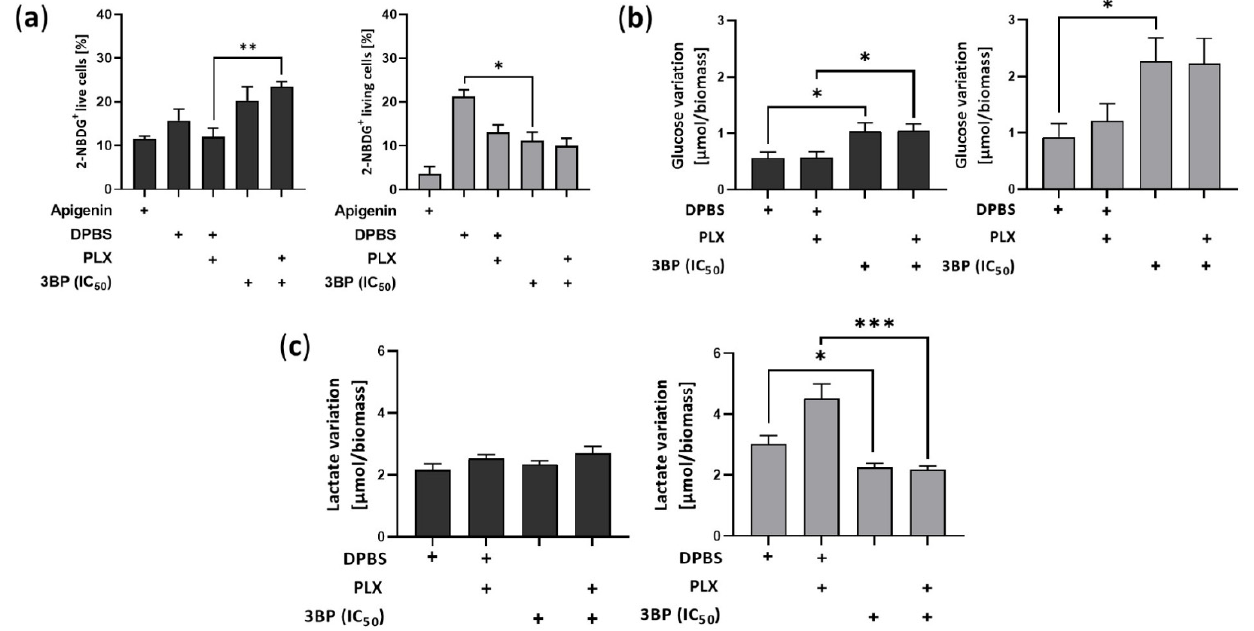
Figure 3. Analysis of variation in extracellular glucose and lactate levels in vemurafenib (PLX)-resistant melanoma cells treated with 3-bromopyruvate (3BP). PLX-resistant melanoma cells were treated with IC 50 3BP, either alone or combined with PLX (4.5 µM for A375R cells and 6.0 µM for SKMEL28R cells). ( a ) Glucose uptake in PLX-resistant melanoma cells treated for 4 h after 7- aminoactinomycin D (7AAD)/ 2-(N-(7-nitrobenz-2-oxa-1,3-diazol-4-yl)amino)-2-deoxyglucose (2NBDG) staining. Data represent the percentage of total cell counts of 7AAD − and 2NBDG+; ( b ) glucose variation (influx) in PLX-resistant melanoma cells treated for 24 h. Data were calculated by the difference between µmol of glucose in culture media at 0 h and after 24 h of treatment. Data were normalized by cell viability analysis using a sulforhodamine B (SRB) assay. ( c ) Lactate variation (efflux) in PLX-resistant melanoma cells treated for 24 h. Data were calculated by the difference between µmol of lactate in culture media after 24 h of treatment and at 0 h. Data were normalized by cell viability analysis using a sulforhodamine B (SRB) assay. Dark gray represents A375R cells; light gray represents SKMEL28R cells. The positive signs in the bar charts indicate the presence of a defined treatment. Data represent the mean ± SEM of at least three independent experiments performed in triplicate. * p ≤ 0.05; ** p ≤ 0.01; *** p ≤ 0.001. 2.3. 3-Bromopyruvate Decreases Cell Division and Induces Cell Death in Vemurafenib-Resistant Melanoma Cells To determine whether the viability impairment caused by 3BP was due to the decline in cell division, a proliferation assay was performed (Figure 4a). The results showed that 3BP decreases cell proliferation in a PLX-independent manner in both the A375R and SKMEL28R cell lines. Supporting these findings, 3BP treatment also significantly restrained the ability of the cell lines to form colonies regardless of the presence of PLX (Figure 4b,c). To determine whether cell death also contributed to the viability decrease caused by 3BP, annexin V and propidium iodide assays were performed (Figures 4d and S4). The results showed that 3BP stimulated A375R and SKMEL28R cell death, independently of PLX. Notably, 3BP monotherapy exhibited a more pronounced effect on A375R cell death than combined therapy. Additionally, 3BP also promoted late apoptosis/necrosis in the SKMEL28R cell line. In an attempt to address other mechanisms of action of 3BP, reactive oxygen species (ROS) release was also evaluated. A significant increase in A375R cells producing ROS was observed after 3BP treatment, although similar results were not observed in the SKMEL28R cell line (Figures 4e and S5).